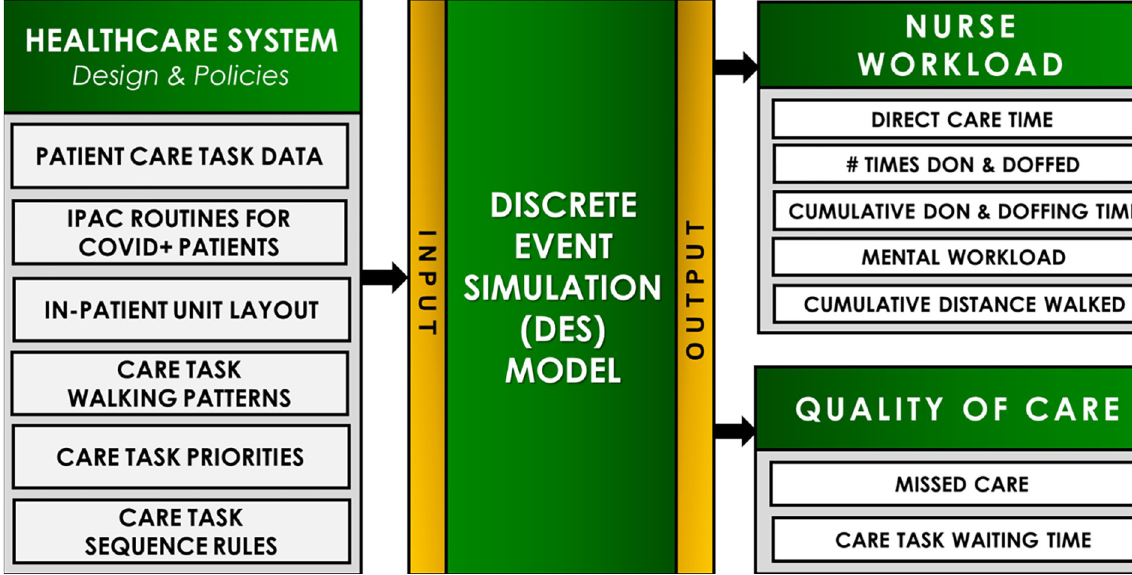
Fig 1. Overview of the model inputs and outputs. Where, Model Inputs are depicted as Healthcare System Design and Policies. Model Outputs include indicators of Nurse Workload and Quality of Care.